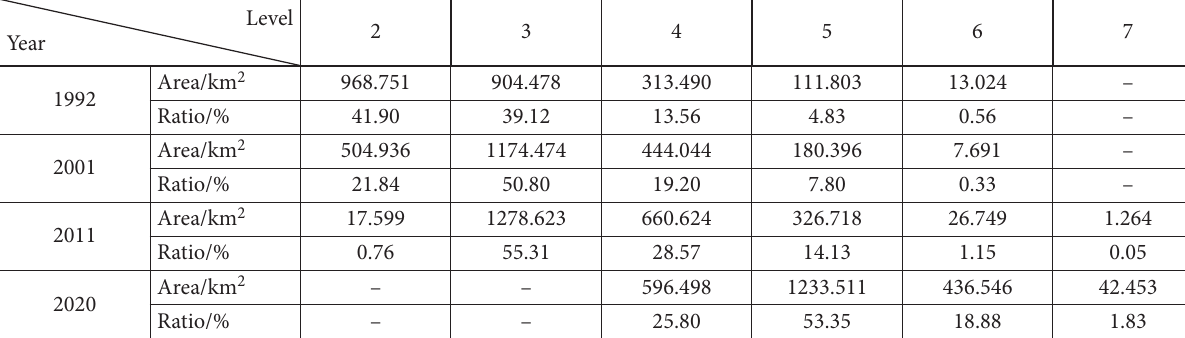
Figure 5. Distribution of the different levels of UHI influence on distress from 1992 to 2020: a) represent 1992; b) represent 2001; c) represent 2011; d) represent 2020 Table 2. Area of the UHI’s influence on